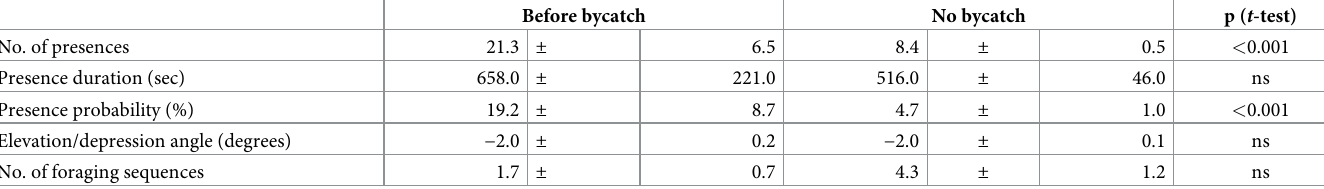
Table 3. Comparison of harbour porpoise behaviour variables between the ‘before bycatch (BB)’ and ‘no bycatch (NB)’ periods (mean ± SE).